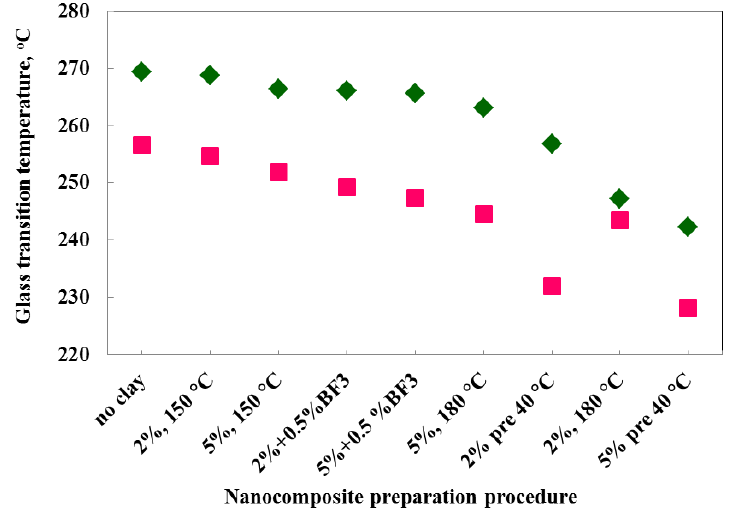
Figure 14. Variation of the dynamic glass transition temperature (or T procedure, obtained by two different techniques: DMA at 1 Hz (green rhombus) and TOPEM at 4 mHz (pink